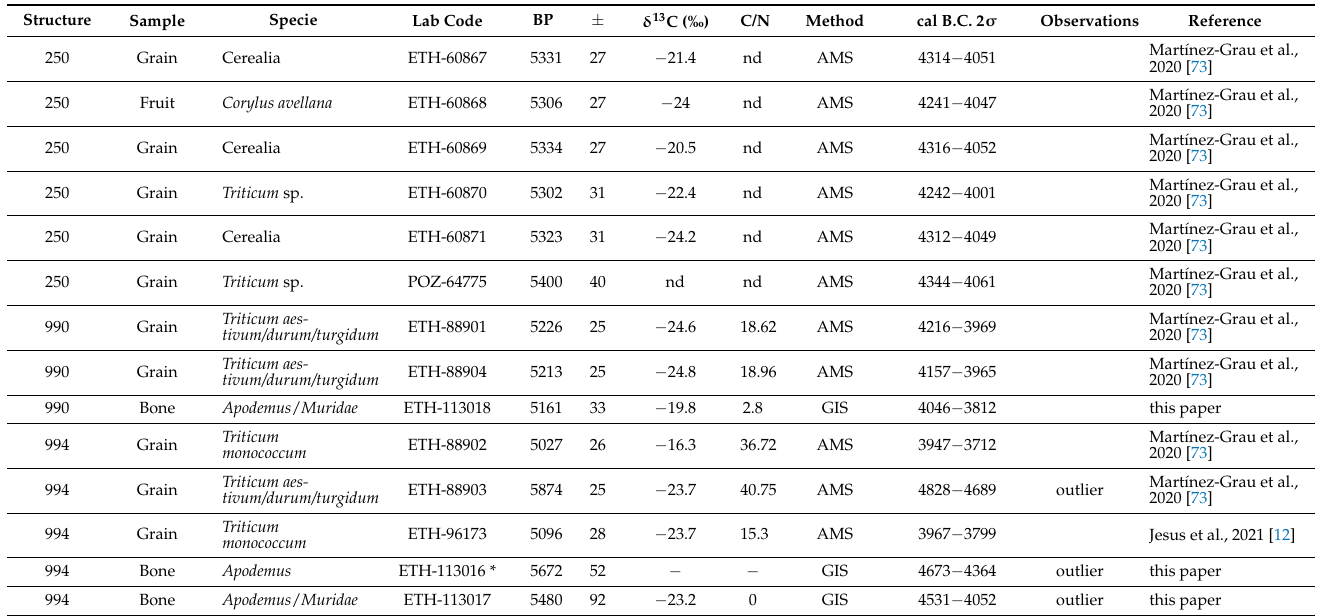
Table 1. Radiocarbon dates of wells 250, 990, and 994 of Les Bagnoles. ETH-113016 * combines two dates from the same sample.